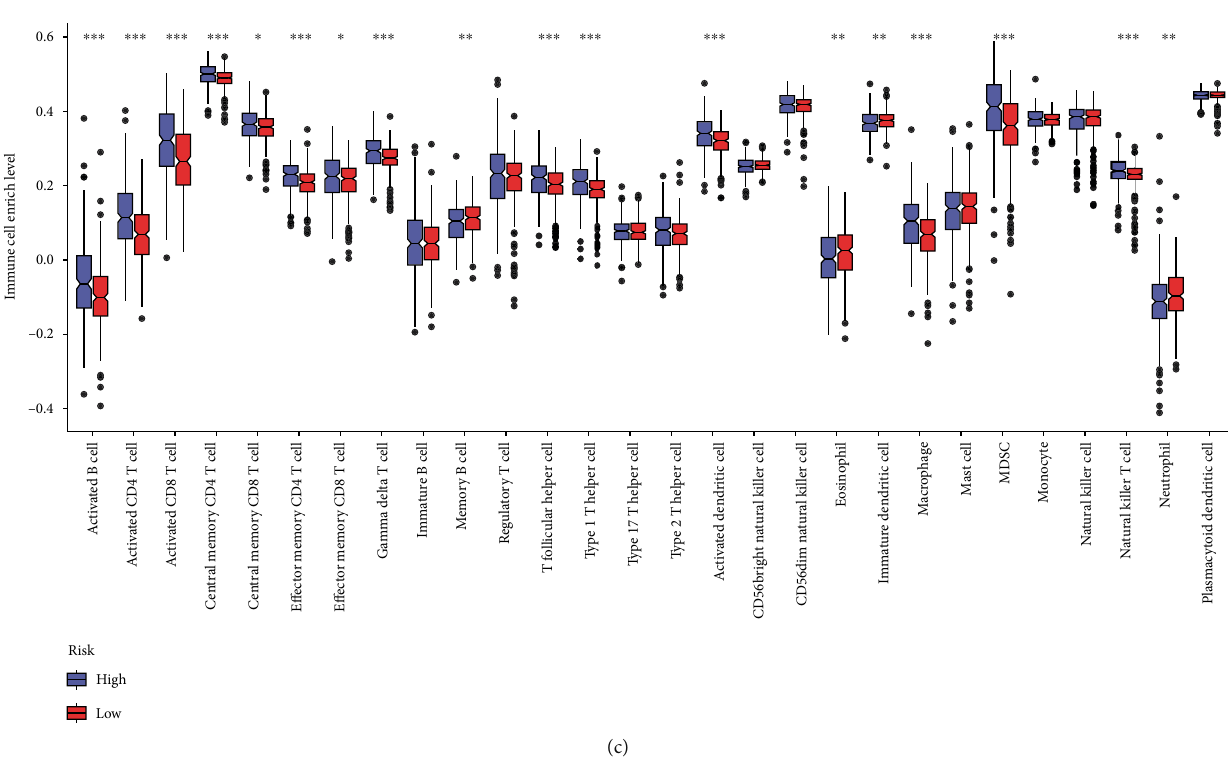
Figure 6: Immune in fi ltration and cancer hallmark heterogeneity between risk scores. (a) Evaluation of the environmental component di ff erences between risk groups by immune score, stromal score, and tumor purity. (b) The correlation between patient risk, cancer hallmark gene set expression (right), and anticancer immunity cycle gene sets (left). (c) The immune cell enriches di ff erences between risk groups presented in a box